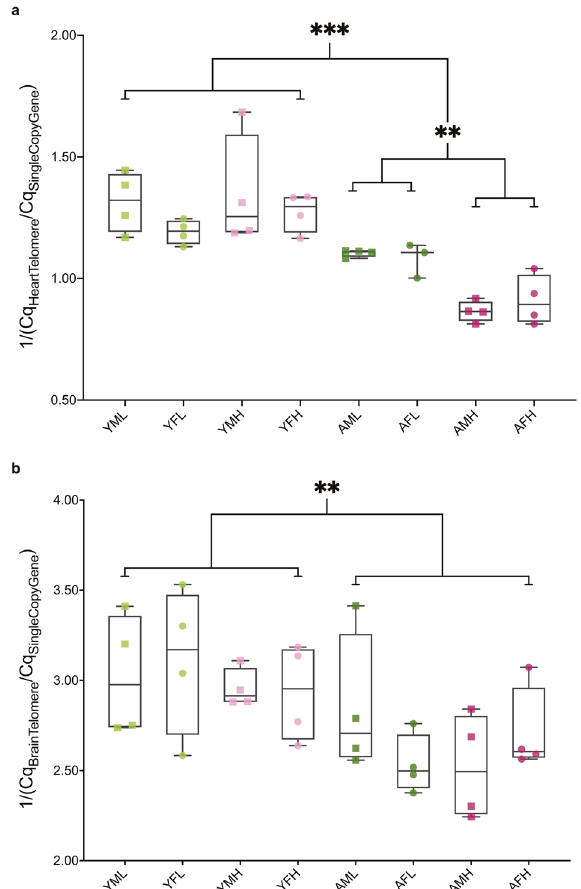
Figure 4. Telomere length shortens with age in both heart and brain and correlates with stress reactivity in the heart, but not brain, of zebrafish. ( a ) Relative telomere length ratios calculated by qPCR for heart tissue grouped by age, sex and stress reactivity ( N = 31). Age and stress reactivity in aging zebrafish have a signficant effect on telomere length in heart tissue. ( b ) Relative telomere length ratios for brain grouped by age, sex and stress reactivity ( N = 32). Only age has a significant effect. Box plots indicate median values (middle lines), first and third quartiles (box edges) and minimum and maximum values (whiskers). YFL young female low stress reactivity, YFH young female high stress reactivity, YML young male low stress reactivity, YMH young male high stress reactivity, AFL aging female low stress reactivity, AFH aging female high stress reactivity, AML aging male low stress reactivity, AMH aging male high stress reactivity. ** p -value < 0.01; *** p -value <